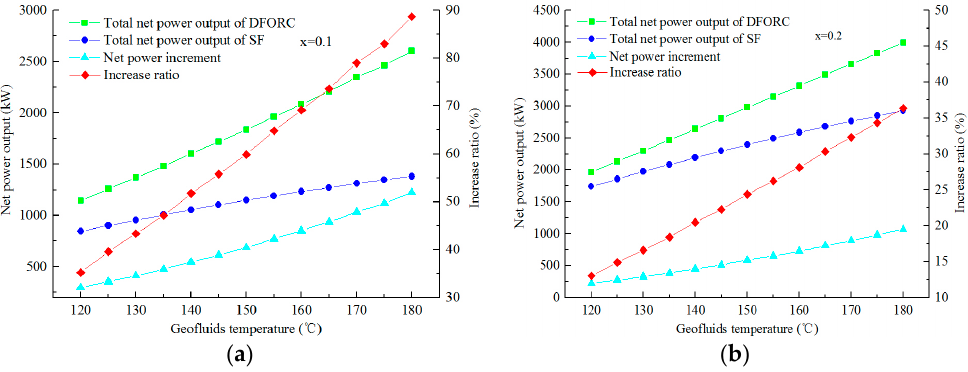
Figure 10. Variations of net power output of DFORC with geofluid temperature: ( a ) x = 0.1; ( b ) x = 0.2.